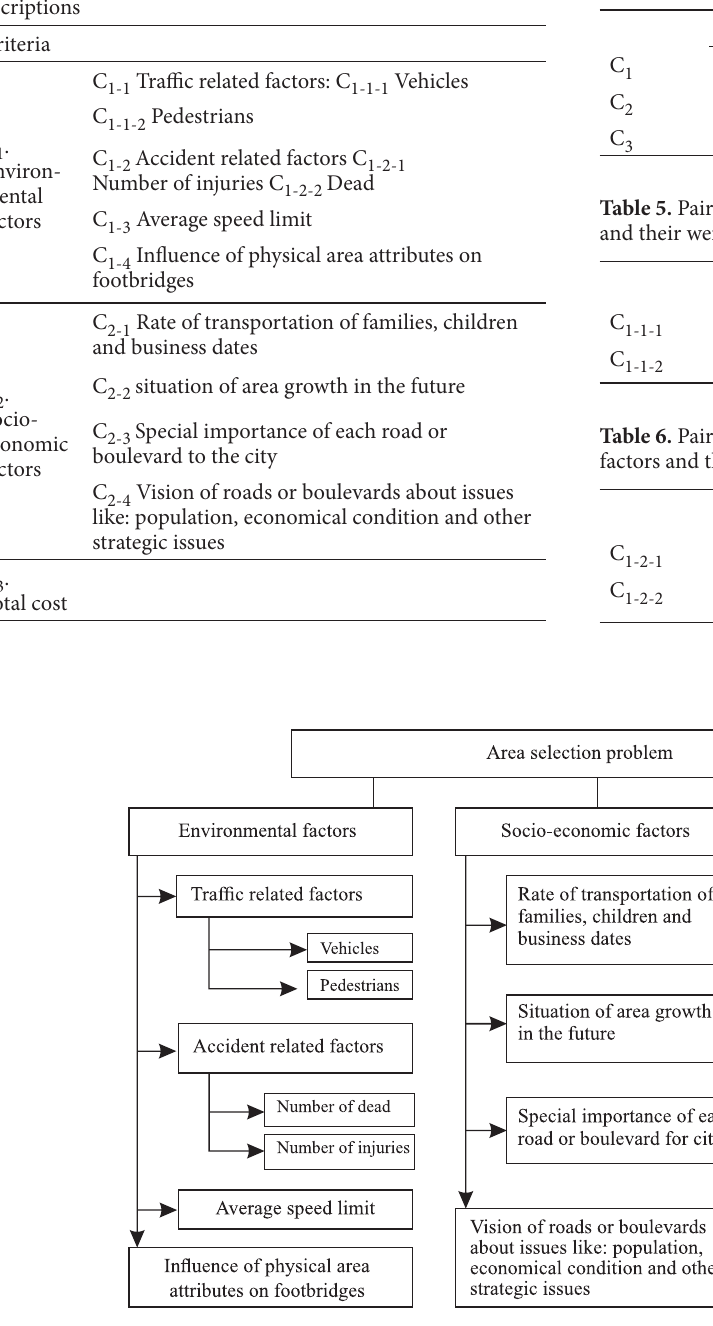
Table 4. Pairwise comparison matrix for criteria and weights